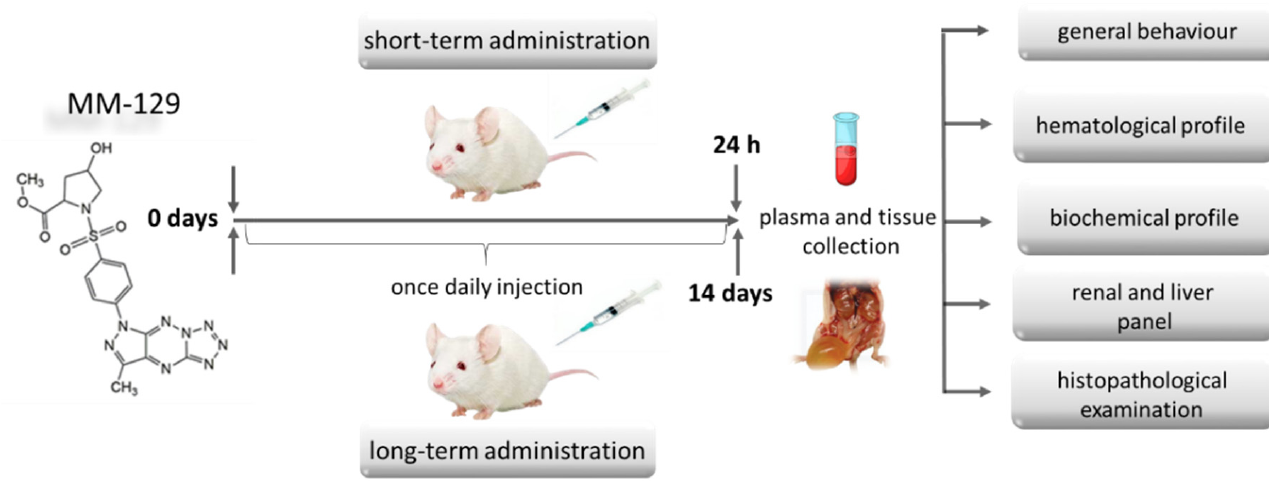
Figure 3. Schematic representation of the study protocol to evaluate the safety of MM-129 in short and long-term toxicity study in BALB/ccmdb mice. Abbreviations: MM-129—pyrazolo[4,3-e]tetrazolo[4,5-b][1,2,4]triazine sulfonamide.